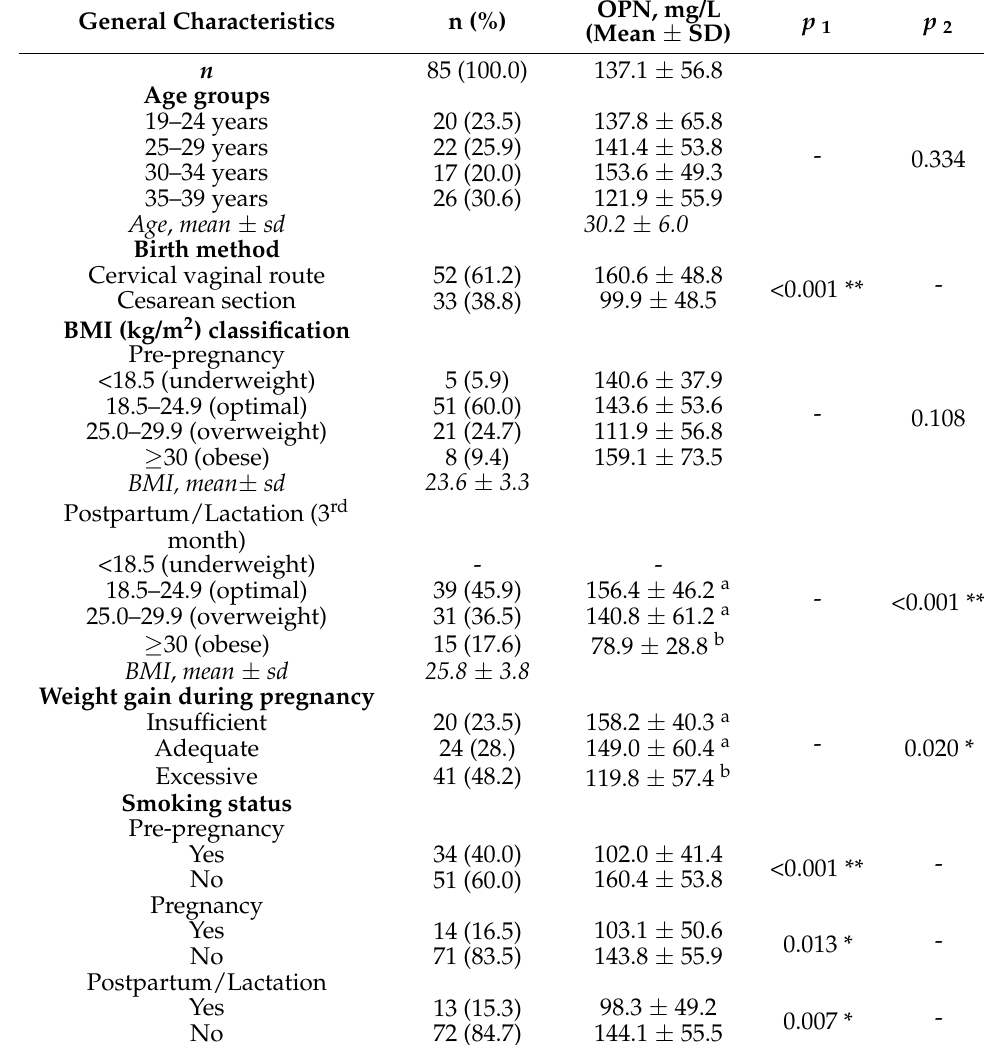
Table 2. General characteristics of the mothers and corresponding breast milk OPN (Osteopontin) levels. General